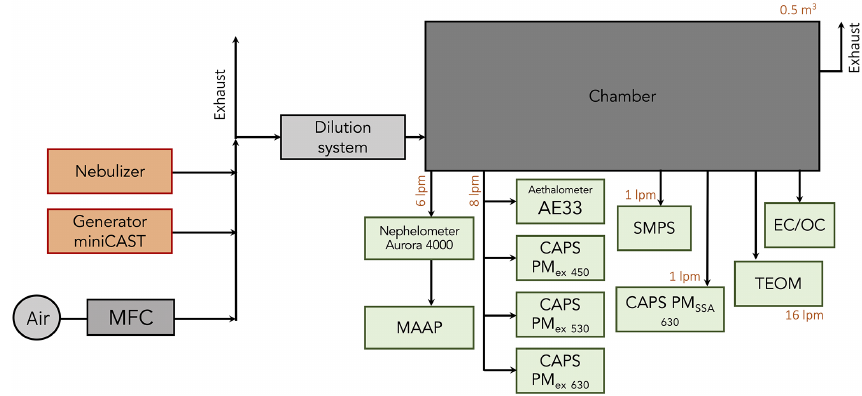
Figure A2. Experimental setup of E2: generation and measurements of BC particles with organics. The black carbon particles are generated using different miniCAST generators operated under flow settings given in Table 1; miniCAST soot generators produce aerosols that are mixed with air from the mass flow controller (MFC). After passing through a dilution system, the aerosols enter the mixing chamber. The black carbon particles are delivered to various instruments measuring physical, optical, and chemical properties. The instruments used in this experiment are the aethalometer (AE33), nephelometer, multi-angle absorption photometer (MAAP), cavity-attenuated phase shift extinction monitor (CAPS PM ex630 ), a cavity-attenuated phase shift extinction monitor (CAPS PM ex530 ), cavity-attenuated phase shift extinction monitor (CAPS PM ex450 ), cavity-attenuated phase shift single-scatter albedo monitor (CAPS PM SSA630 ), mobility particle size spectrometer (MPSS), and tapered element oscillating microbalance